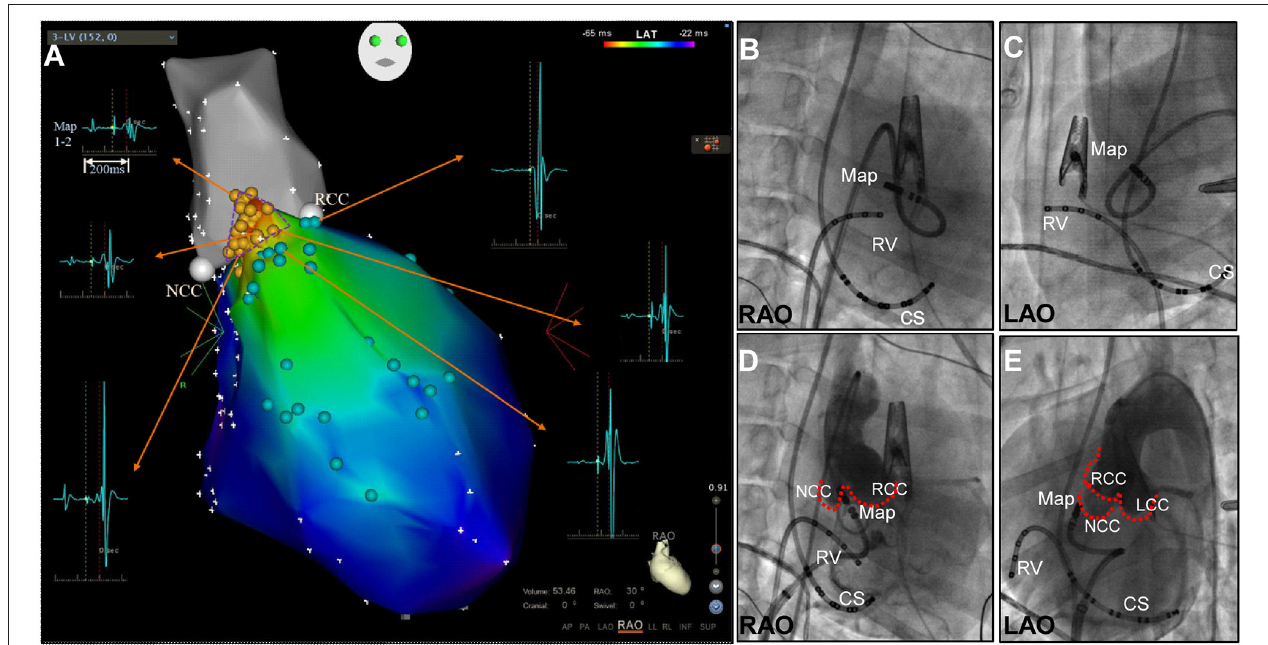
FIGURE 1 | (A) Three-dimensional mapping of the aortic root (grey) and upper septal region in the left ventricle in right anterior oblique (RAO) view. A small triangular area with His activation was found between the NCC and RCC. His activation (yellow points), bundle branch potential and branches (light green points). (B-E) Fluoroscopic right anterior oblique (RAO) and left anterior oblique (LAO) views demonstrating mapping at the apex of the NCC-RCC junction via the retrograde transaortic approach (B,C) and transseptal approach with the reverse S-curve (D,E) . CS, coronary sinus; LCC, left coronary cusp; Map, mapping catheter; NCC, non-coronary cusp; RCC, right coronary cusp; RV, right ventricle.